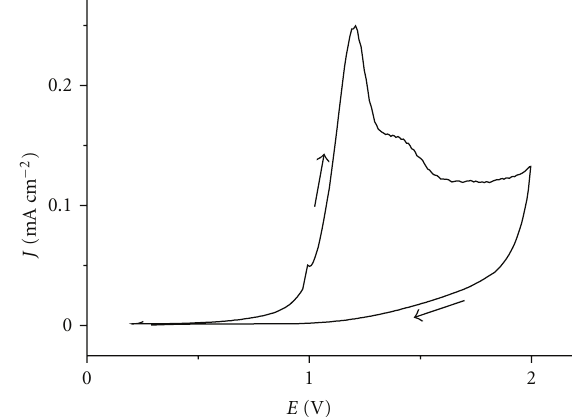
Figure 12: Cyclic voltammograms in phenol-containing solution. Potential scan rate 20mV/s. Arrows show the direction of potential